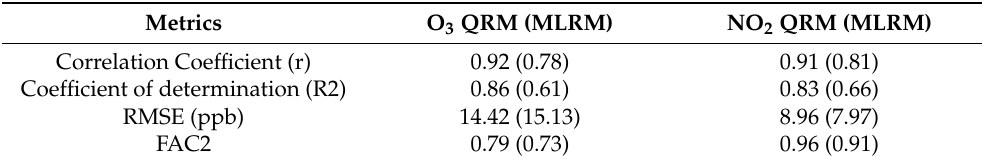
Figure 7. Graphical comparison of observed and predicted O 3 concentrations (ppb) ( right -panels) and NO 2 concentrations (ppb) ( left -panels) for testing data. Table 5. Statistical metrics for cross-validated models using 25% of the randomly selected testing dataset. The values outside of the parenthesis are for quantile regression (QRM) and inside are for multiple linear regression model